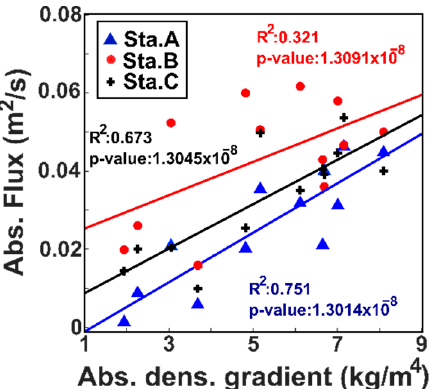
Figure 12. The longitudinal subtidal density gradient vs. return flux at Stations A (blue triangles), B (red dots), and C (black plus). The trendlines denote the linear relationship between the density gradient with return flux in each respective station.